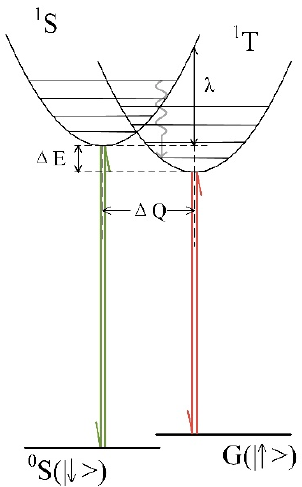
Figure 1. A schematic four-level system for our model. Electrons non-radioactively decay from singlet state 1 S to triplet state 1 T. The displacement Δ Q corresponds to different equilibrium geometries in 1 S and 1 T. Δ E is the energy gap between the lowest vibrational levels and λ is the electron-phonon self-energy difference. These two parameters are associated with the Franck-Condon factor.